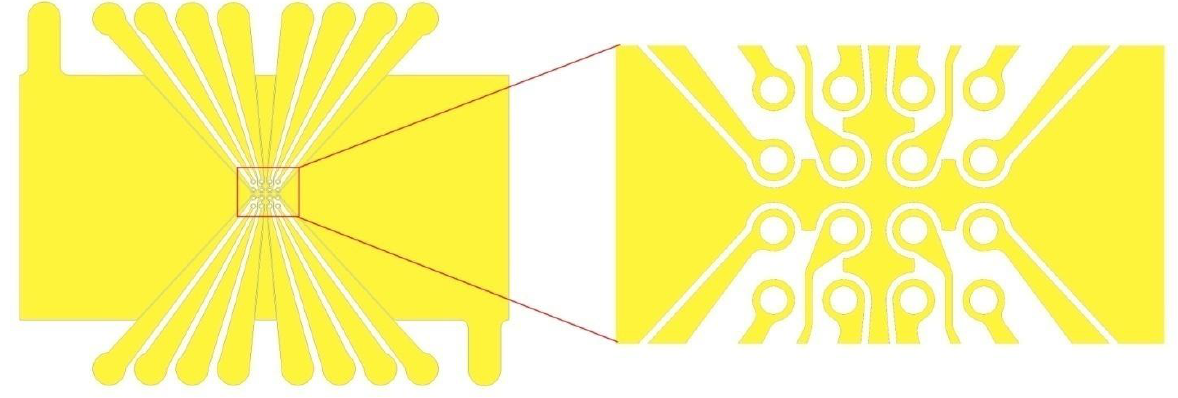
Figure 4. A schematic illustration of the proposed 4x4 microarray dot electrode geometry used in our LOC device.